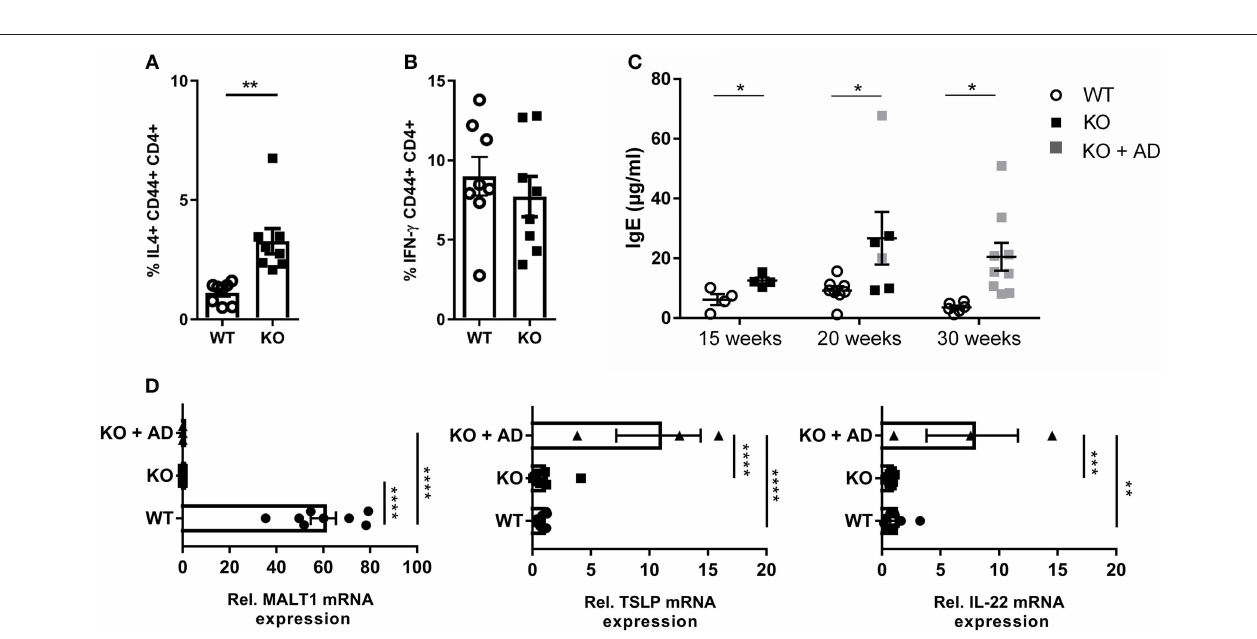
FIGURE 5 | Th2 skewing and elevated IgE levels in Malt1 -KO mice. (A) Splenocytes of 20 weeks old mice without skin lesions were stimulated for 4h with PMA and IO (same for B), in order to determine the percentage of CD44 + CD4 + T cells expressing IL-4 (WT and KO: n = 8). (B) Percentage of CD44 + CD4 + T cells expressing IFN- γ (WT and KO: n = 8). (C) IgE levels in serum collected from WT and Malt1 -KO mice of ± 15, ± 20, and > 30 weeks (15 weeks WT and KO: n = 4, at 20 weeks WT: n = 8 and KO: n = 6 and at 30 weeks WT: n = 6 and KO: n = 9). Open circles (WT), black squares (KO), and gray squares (KO + AD) represent individual mice. (D) mRNA expression levels of Malt1 , Tslp , and IL22 (relative to reference genes Hprt1 and Ubc ) in ears of Malt1 -WT mice ( n = 7), Malt1 -KO mice ( n = 11), and Malt1 -KO + AD mice ( n = 3) suffering from dermatitis. The mean ± SEM is indicated on the graphs. For (A–C) all results were obtained by flow cytometry the statistical significance between groups was calculated with an unpaired 2-tailed Student’s t -test. For (D) the statistical significance between groups was calculated with a one-way ANOVA with a Tukey’s multiple comparison test. * P < 0.05, ** P < 0.01, *** P < 0.001, and **** P <